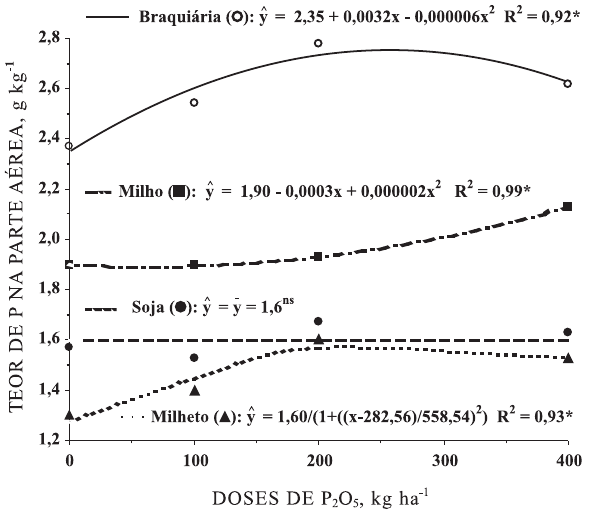
Figura 3. Teor de P na fitomassa do milheto, braquiária, soja e milho aos 50 dias da emergência das plantas, em função da adubação com fosforita Alvorada. ns: não-significativo. * significativo a 5 %.